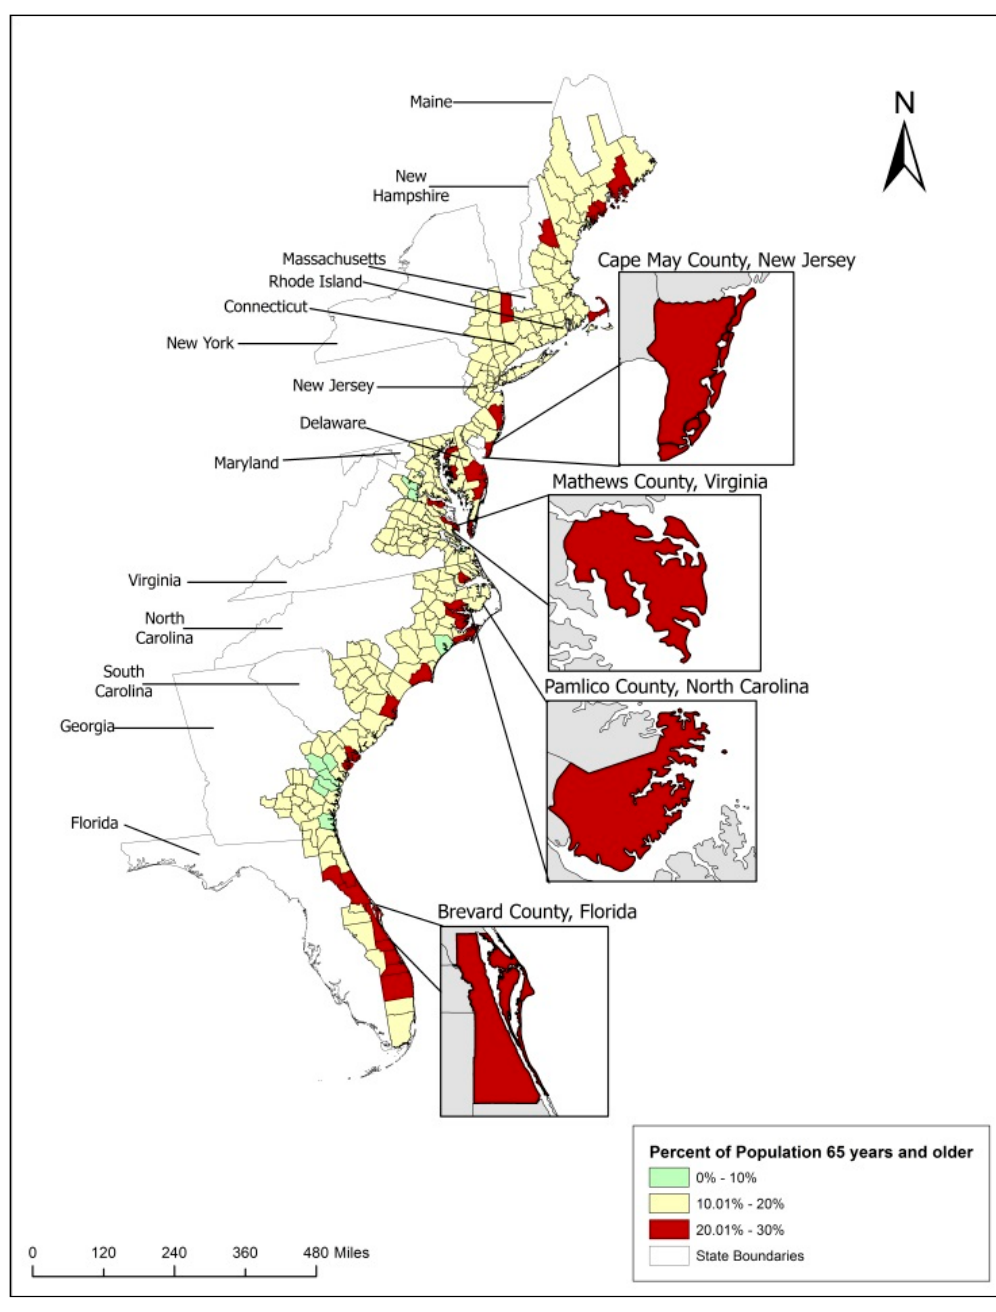
Figure 1. Older populations in coastal counties along the East Coast and the location of selected case studies (percent of people age 65 and older).